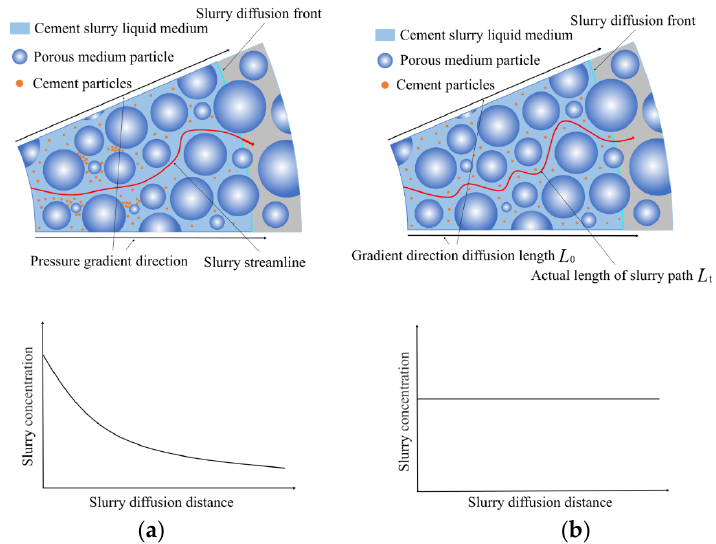
Figure 1. Comparison of different tortuous models: ( a ) uneven filtration tortuous model; [1] ( b ) simplified tortuous model.